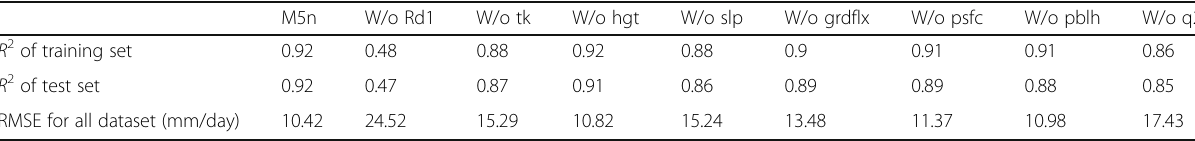
Table 9 Performance statistics for ANN sensitivity analysis for 1996 – 1998 dataset